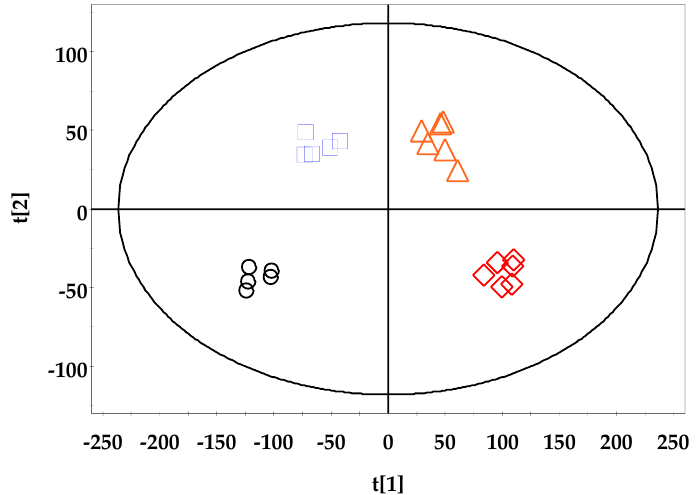
Figure 8. OPLS-DA score plot based on the 1 H-NMR spectra of the DSS-treated group and control group. ○ : DSS 0%; □: DSS 2%; △ : DSS 3.5%; ◇ : DSS 5% ( R 2 X = 0.738, R 2 Y = 0.919, and Q 2 =